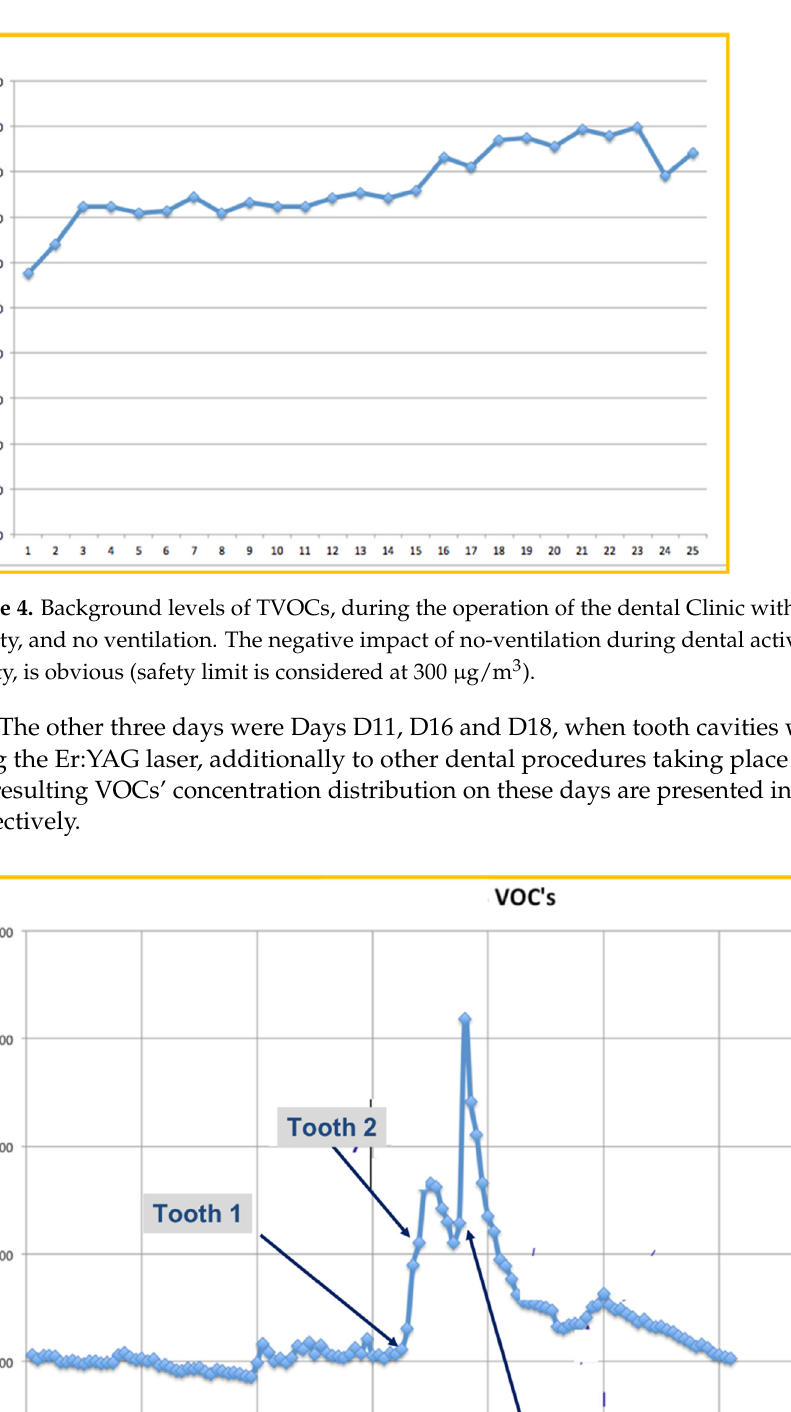
Figure 6. TVOCs on D16. Windows were open and Er YAG Laser was in use from 11:50 to 12:20 (1- h recording).